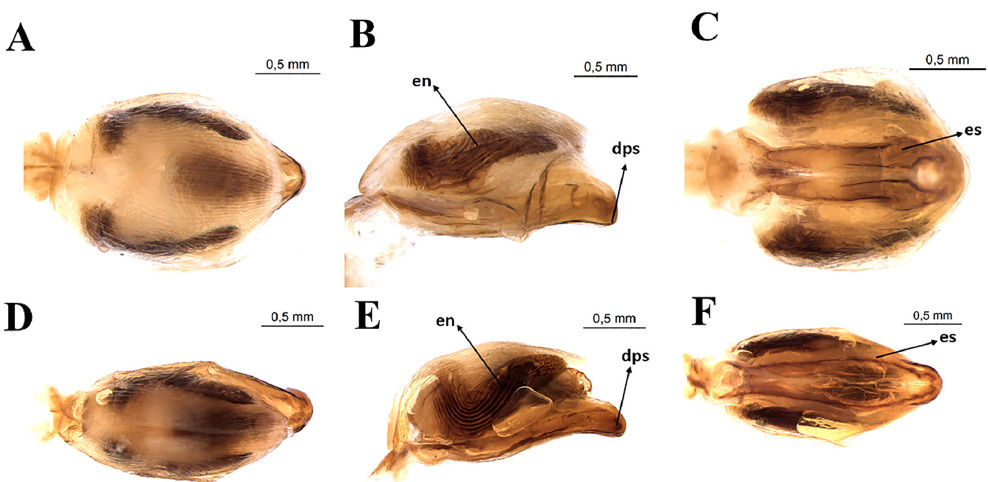
Figure 9. Phallus of T. rosai sp. nov.: ( A ) dorsal view, ( B ) lateral view, ( C ) ventral view; T. sordida : ( D ) dorsal view, ( E ) Lateral view, ( F ) ventral view. en: endosoma, dps: dorsal phallothecal sclerite, es: endosoma struts.